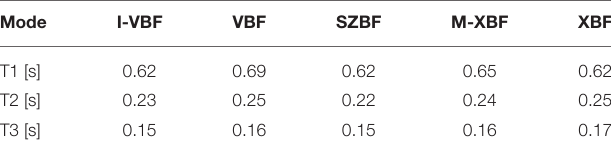
TABLE 2 | Structural periods of